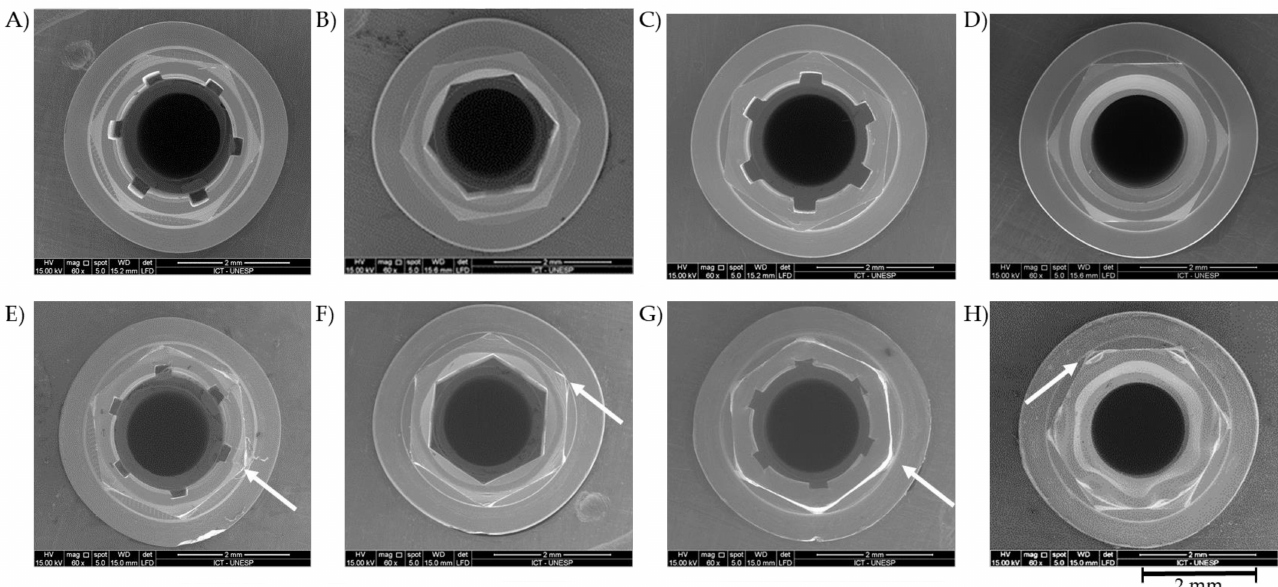
Figure 1. Initial ( A – D ) and final conditions ( E – H ) of representative implants subjected to the fatigue testing. The arrows point out the plastic deformations of the hexagons.